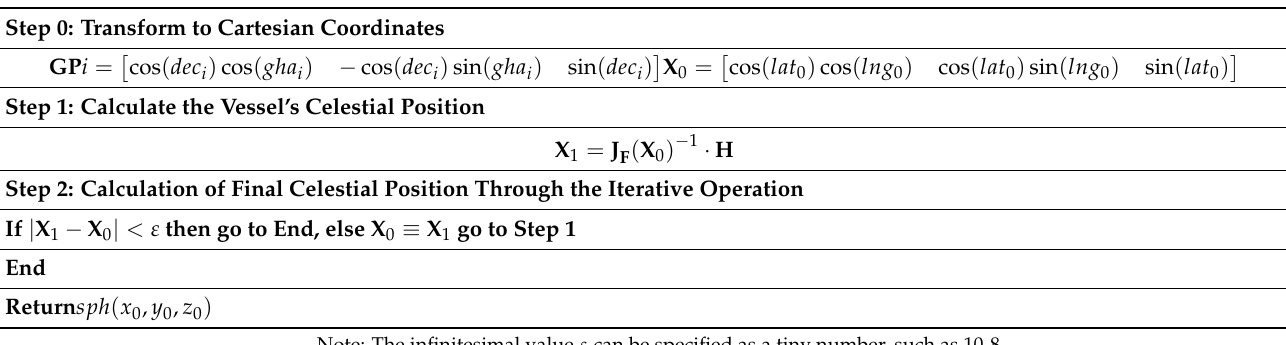
Table 1. Scenario 1: iterative calculation procedure.